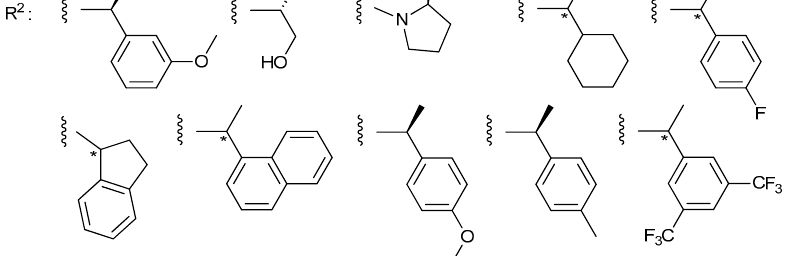
Figure 36. A set of new chiral thioureas (left) prepared by Yan et al.and the most active indane derivative (right) tested against TMV [361].